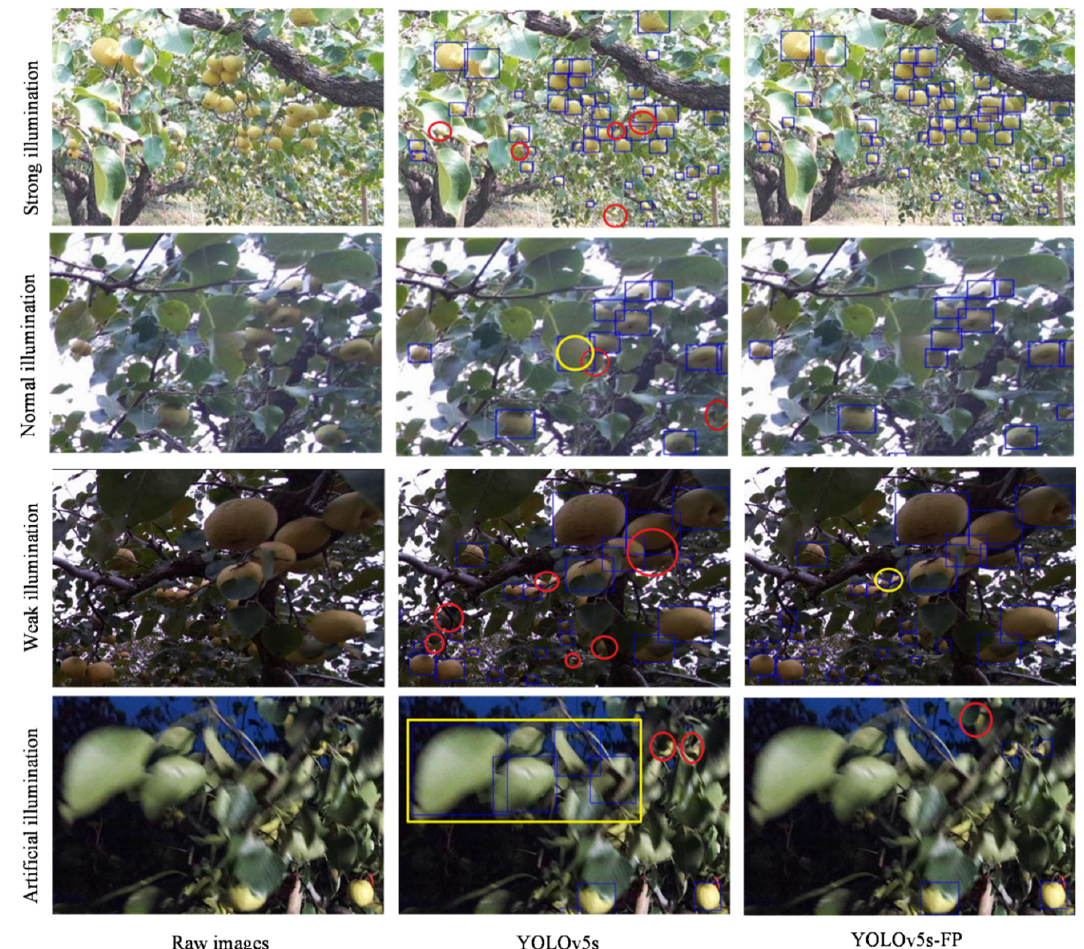
Figure 10. Comparison of pear detection results under different illumination conditions, where missing pears were marked in red and false detection pears were marked in yellow. Table 6. Detection accuracy of two networks under different illumination conditions.